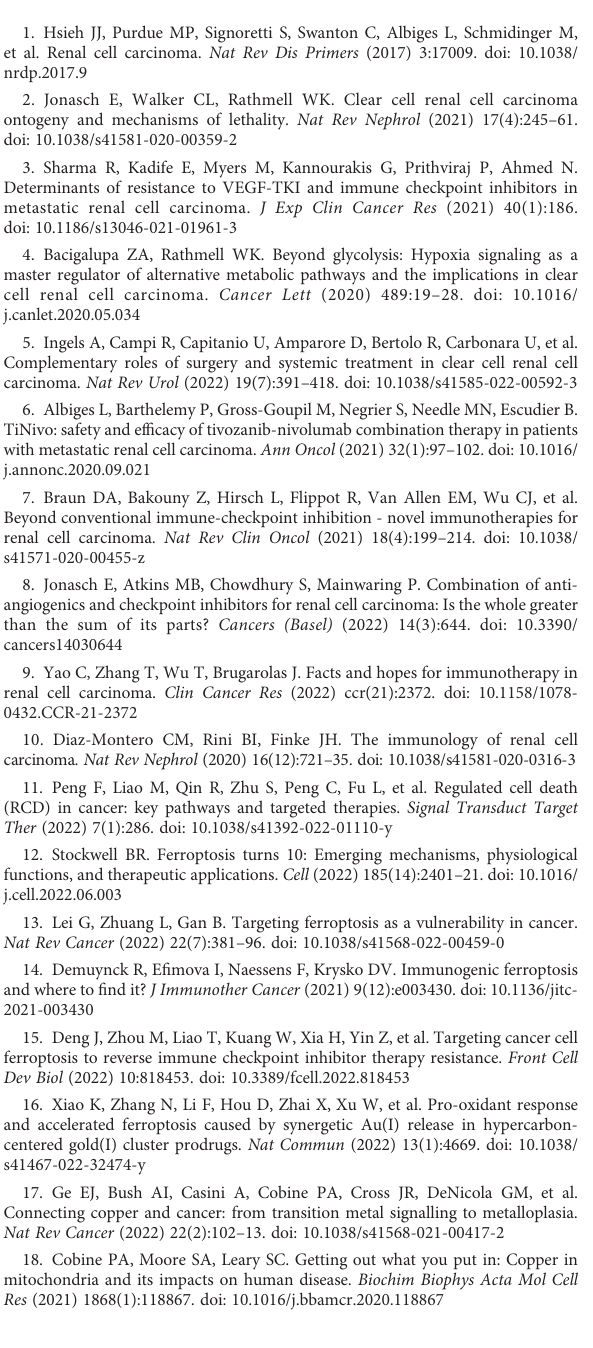
SUPPLEMENTARY FIGURE 2 Kaplan-Meier Curves for differential survival of two cuproptosis phenotypes in the merge cohort which contains two datasets: TCGA and E-MTAB-1980.